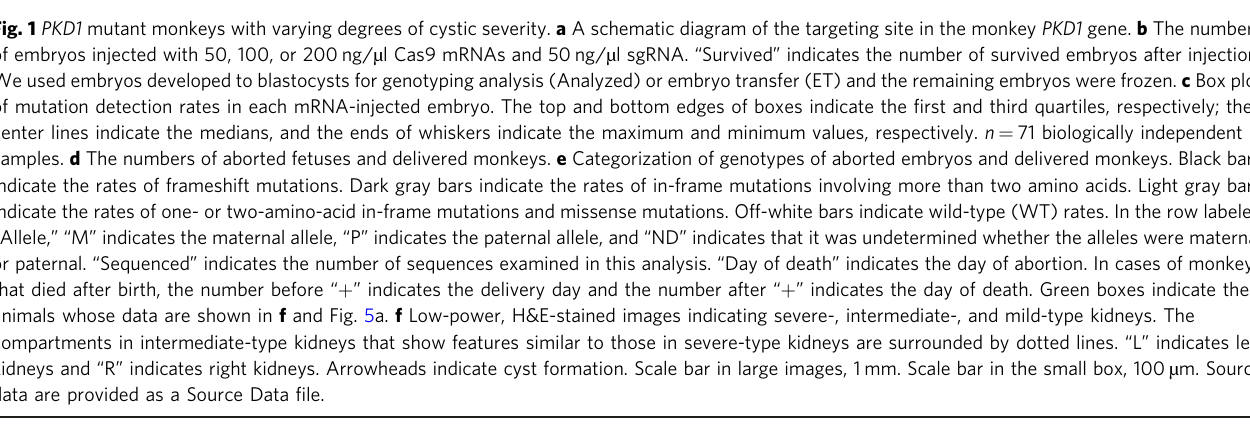
Fig. 1 PKD1 mutant monkeys with varying degrees of cystic severity. a A schematic diagram of the targeting site in the monkey PKD1 gene. b The numbers of embryos injected with 50, 100, or 200 ng/ µ l Cas9 mRNAs and 50 ng/ µ l sgRNA. “ Survived ” indicates the number of survived embryos after injection. We used embryos developed to blastocysts for genotyping analysis (Analyzed) or embryo transfer (ET) and the remaining embryos were frozen. c Box plot of mutation detection rates in each mRNA-injected embryo. The top and bottom edges of boxes indicate the fi rst and third quartiles, respectively; the center lines indicate the medians, and the ends of whiskers indicate the maximum and minimum values, respectively. n = 71 biologically independent samples. d The numbers of aborted fetuses and delivered monkeys. e Categorization of genotypes of aborted embryos and delivered monkeys. Black bars indicate the rates of frameshift mutations. Dark gray bars indicate the rates of in-frame mutations involving more than two amino acids. Light gray bars indicate the rates of one- or two-amino-acid in-frame mutations and missense mutations. Off-white bars indicate wild-type (WT) rates. In the row labeled “ Allele, ” “ M ” indicates the maternal allele, “ P ” indicates the paternal allele, and “ ND ” indicates that it was undetermined whether the alleles were maternal or paternal. “ Sequenced ” indicates the number of sequences examined in this analysis. “ Day of death ” indicates the day of abortion. In cases of monkeys that died after birth, the number before “ + ” indicates the delivery day and the number after “ + ” indicates the day of death. Green boxes indicate the animals whose data are shown in f and Fig. 5a. f Low-power, H&E-stained images indicating severe-, intermediate-, and mild-type kidneys. The compartments in intermediate-type kidneys that show features similar to those in severe-type kidneys are surrounded by dotted lines. “ L ” indicates left kidneys and “ R ” indicates right kidneys. Arrowheads indicate cyst formation. Scale bar in large images, 1 mm. Scale bar in the small box, 100 µ m. Source data are provided as a Source Data fi